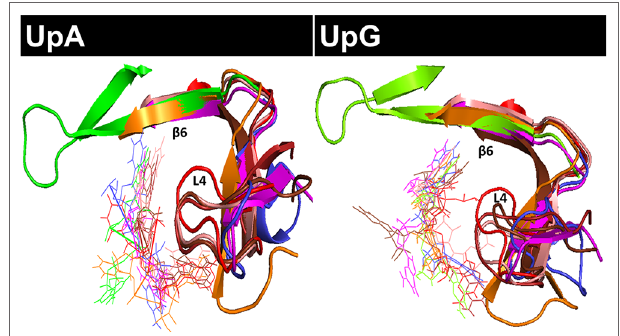
FIGURE 4 | Overlapping of all RNase-UpA and RNase-UpG complexes obtained by molecular dynamics (see Figures 3 and S6 ). The secondary base binding site (B2) is highlighted (loop L4 and strand β 6). As shown in Figure 3 , the molecules are colored according to vertebrate groups as indicated in the family phylogenetic tree (see Figure S2 ). Mammal RNases are shown in shades of red, turtle RNase in magenta, chicken RNase in orange, frog RNase in green and fish RNase in blue.